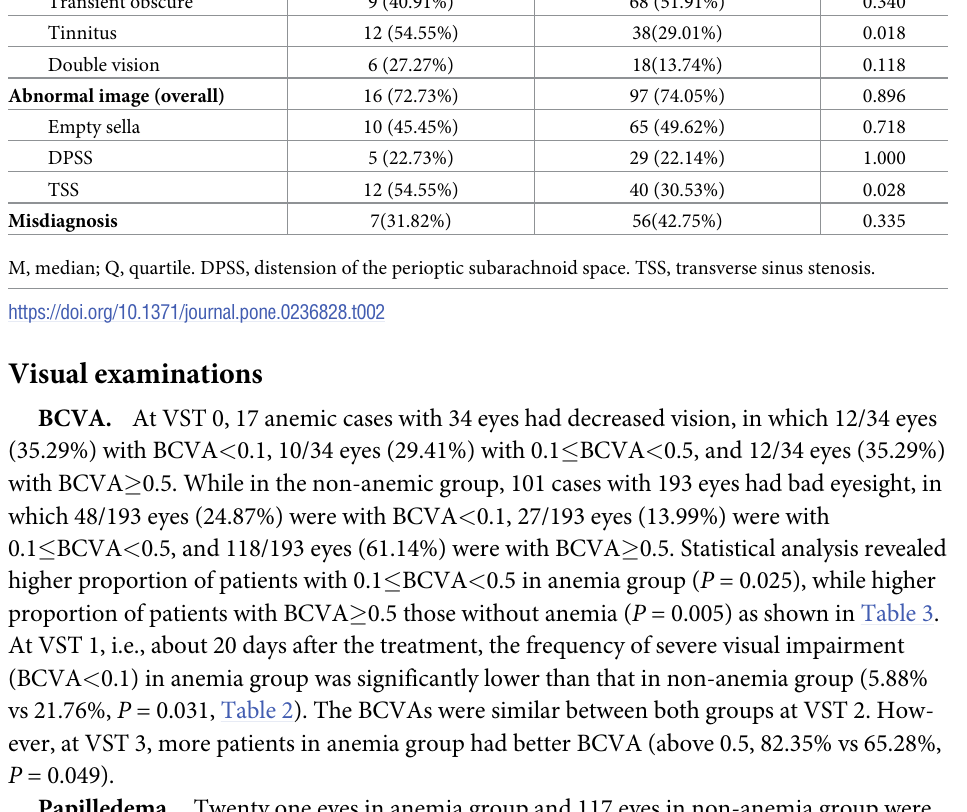
Table 2. Clinical and neuroradiological characteristics of IIH patients in the two groups at baseline. With anemia (n = 22) Without anemia (n = 131) P value Course of disease (month) M = 1.00, Q = 1.43 M = 3.00, Q = 6.00 0.00 Symptoms Vision loss 18 (81.81%) 115 (87.78%) 0.317